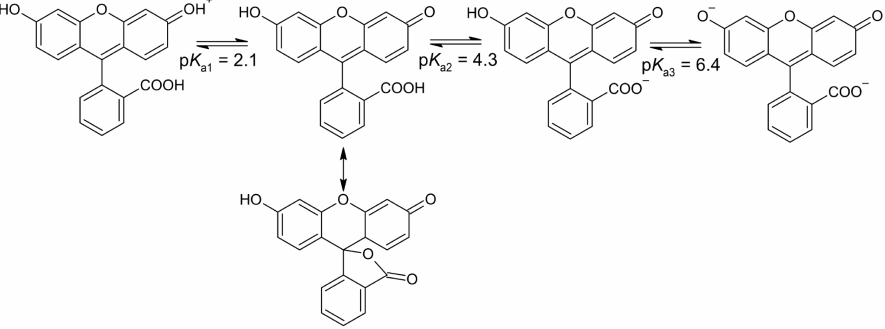
Figure 1. Forms of fluorescein in different acidity regions